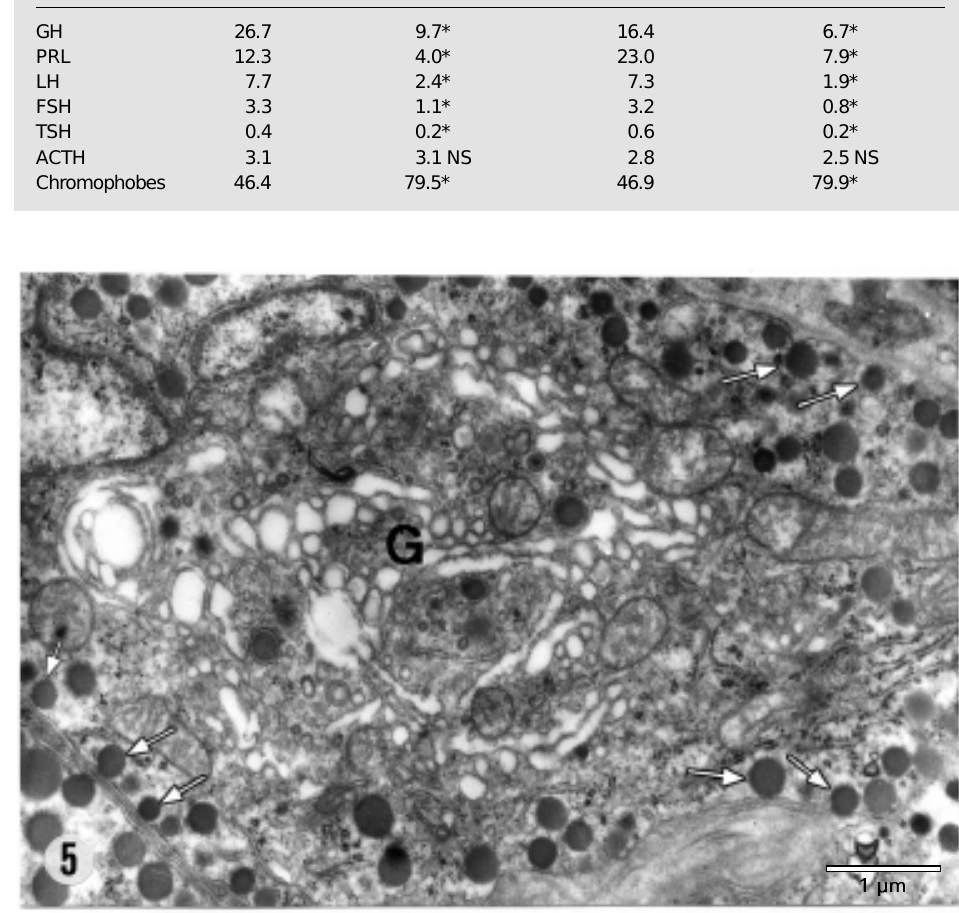
Table 2 - Percent distribution (% volume density) of the different pituitary cell populations in undernourished and control monkeys.